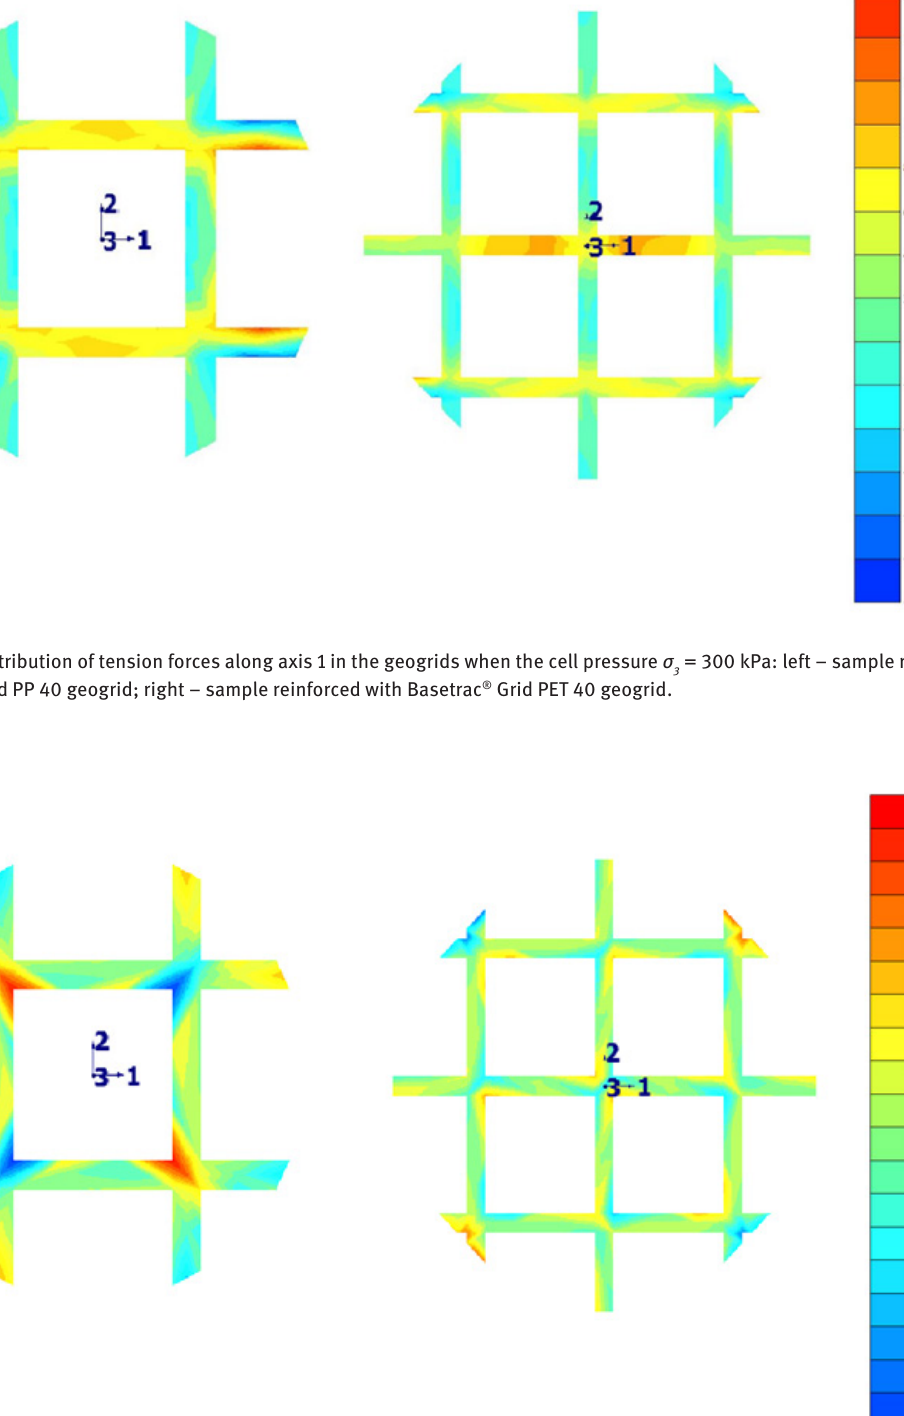
Figure 11: Distribution of shear forces in the geogrids when the cell pressure σ 40 geogrid; right – sample reinforced with Basetrac ® Grid PET 40